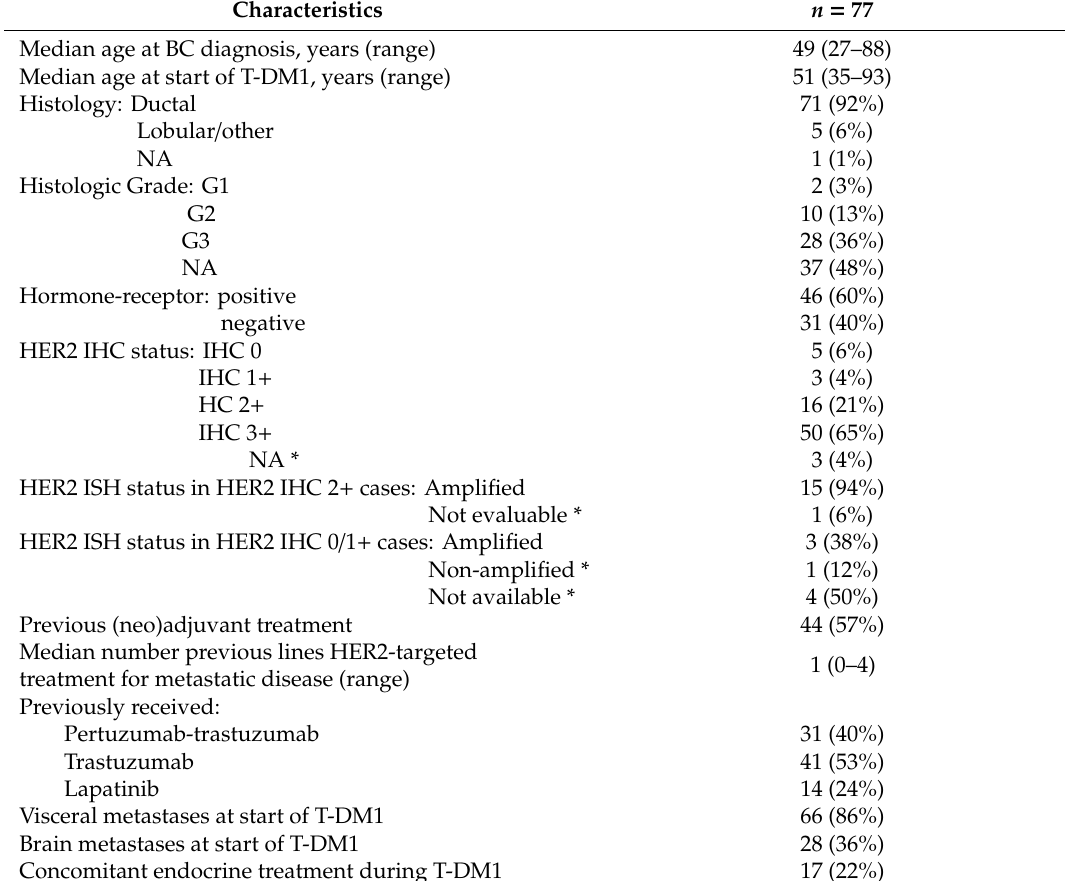
Table 1. Patient